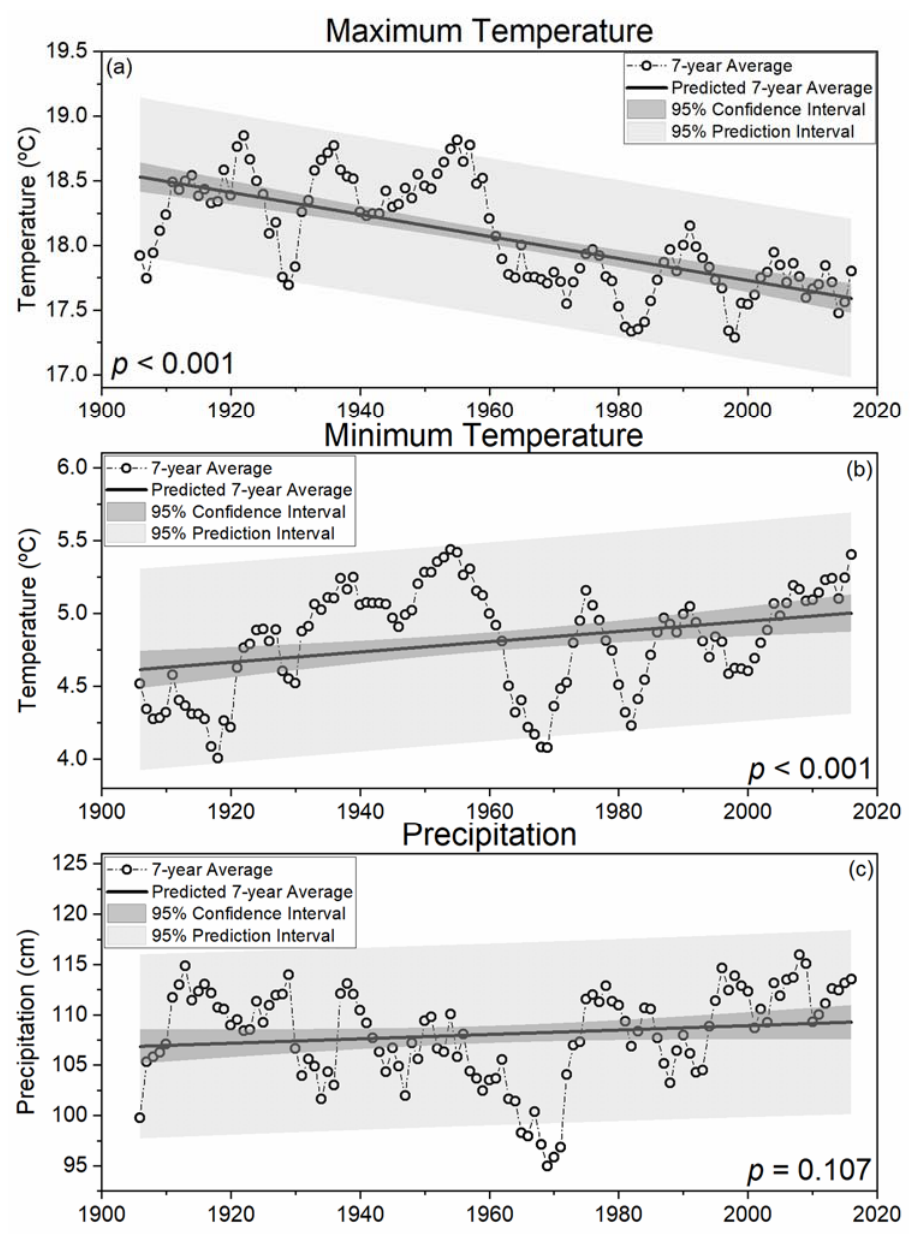
Figure 2. Seven-year moving averages of state averaged ( n = 18) maximum temperature (( a ); °C), minimum temperature (( b ); °C), and total annual precipitation (( c ); cm) for West Virginia, USA.